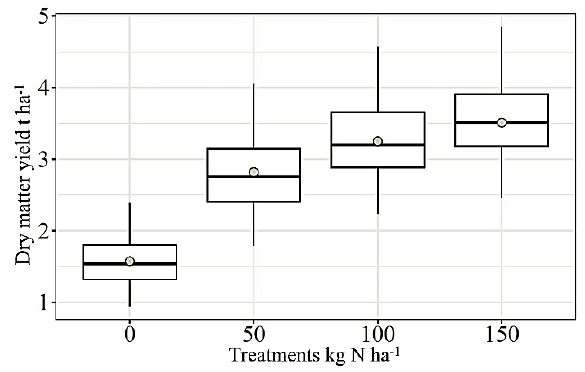
Fig. 2. Dry matter yield (t ha -1 ) per treatment. Point in box represents mean of dry matter yield (t ha -1